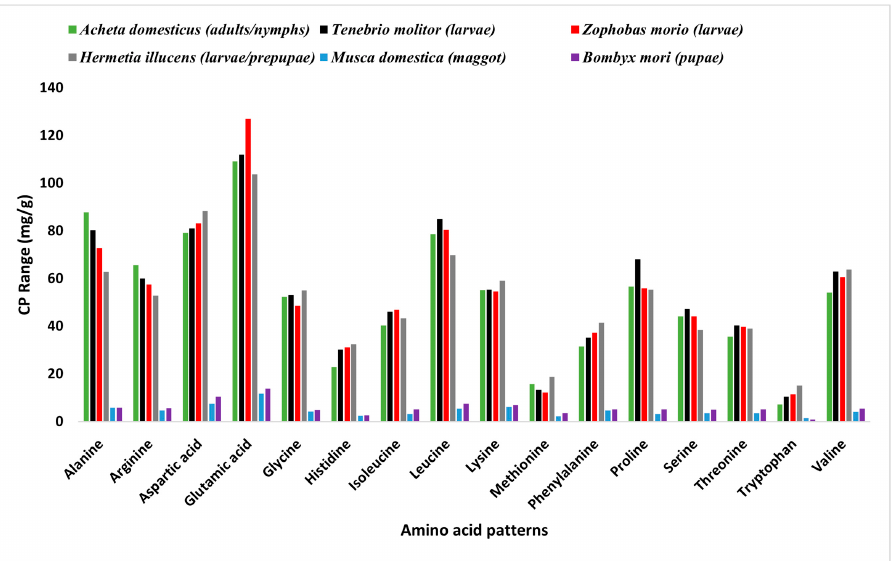
Figure 2. Patterns of amino acids (mg/g CP) of six commonly used edible insect species. Sources